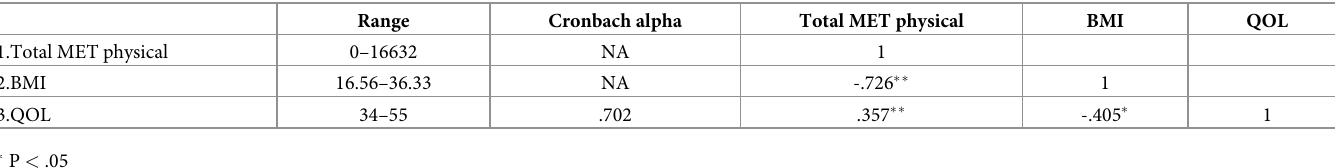
Table 2. Correlation and internal consistency of the variables.